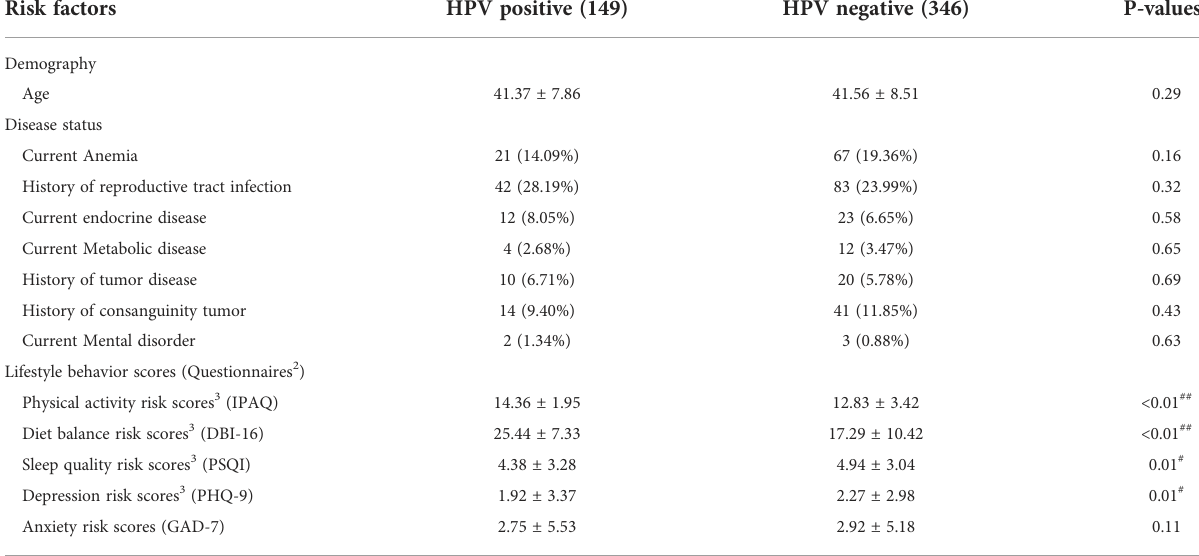
TABLE 1 HPV statistics for age, disease status and lifestyle